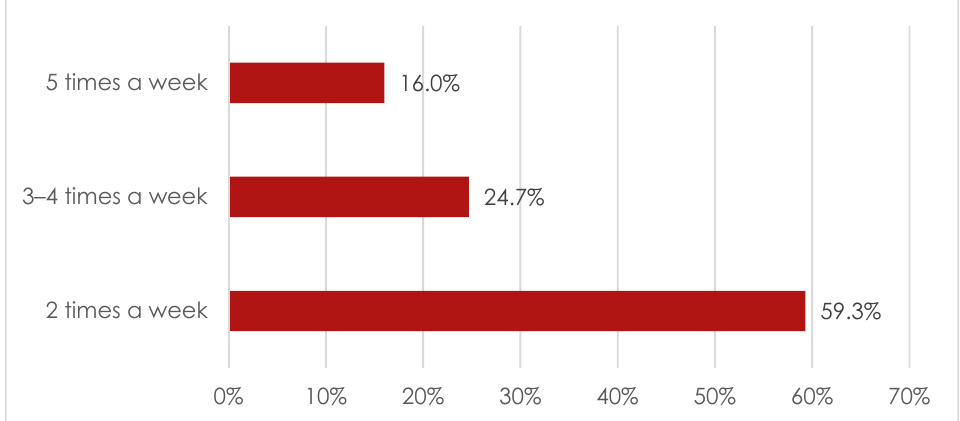
Figure 2. Graphic representation of frequency of yoga practice among practitioners. Table 3. Comparative characteristics of determinants of quality of life, quality of life satisfaction, and own health satisfaction in both the SG and